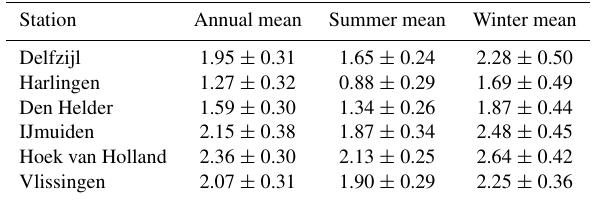
Table 1. Trends in sea level rise and 95% confidence intervals (all in mmyr − 1 ) for annual and seasonal half-year means. (Derived from 100-year records, 1916–2015, supplied by Rijkswaterstaat and